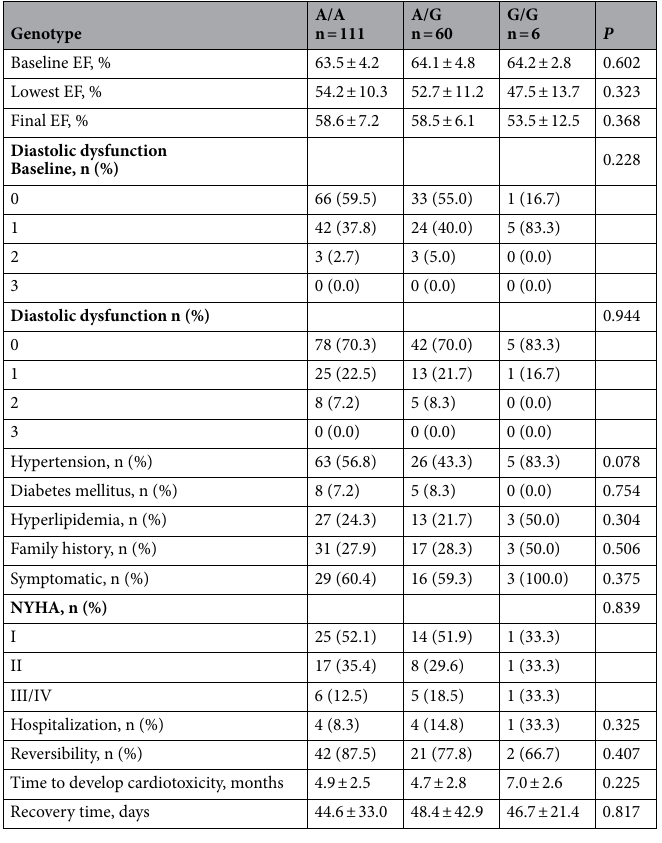
Table 2. Differences in cardiac function and comorbidities depending on HER2 / neu genotype. A Adenin, G Guanine, EF Ejection Fraction, NYHA New York Heart Association, P value was calculated with one-way analysis of variance (ANOVA).